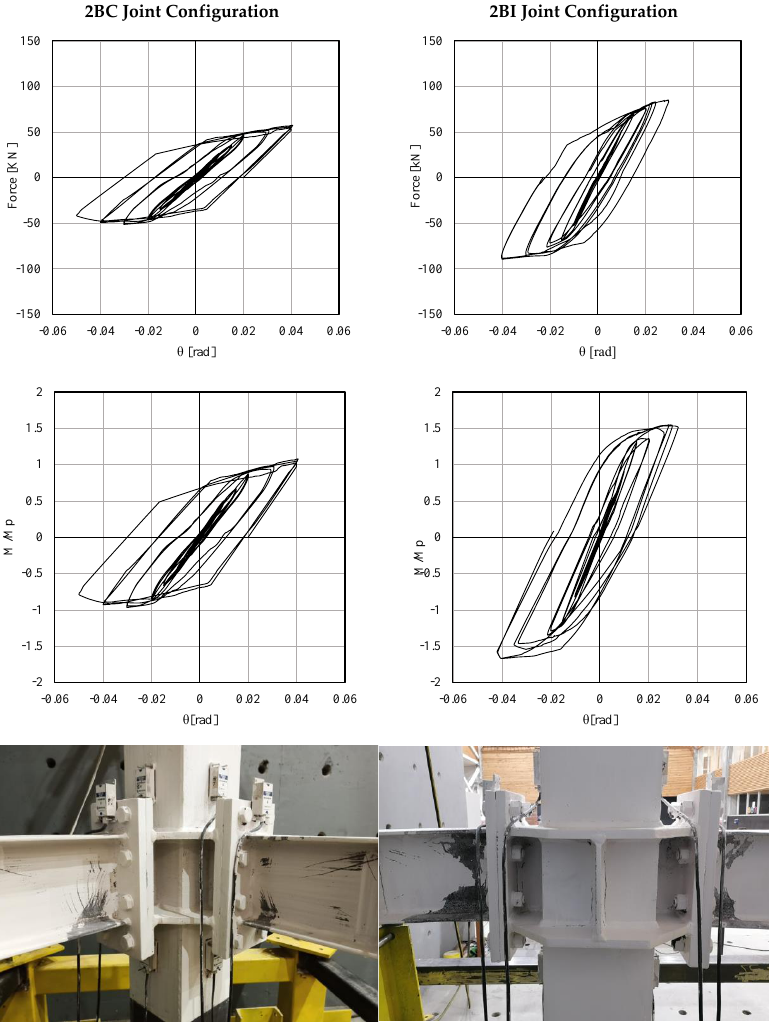
Figure 4. Force-rotation curves and normalized moment-rotation curves of beam and failure mech- anisms at 0.04 rad of the specimens tested.